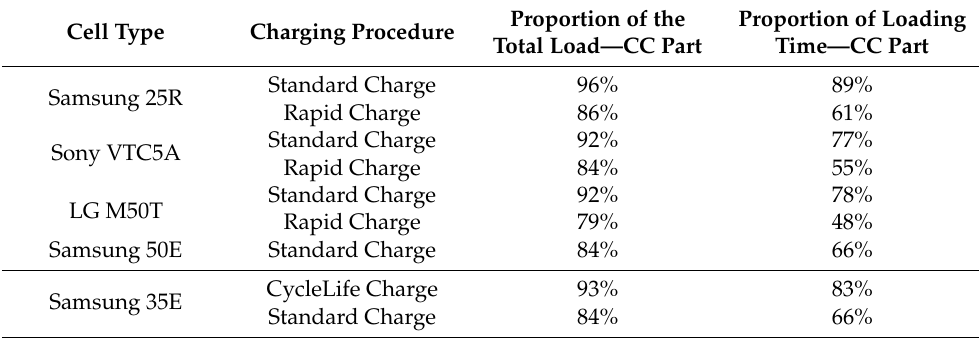
Table 5. Proportion of the total load and loading time of the CC part after the first cycle.